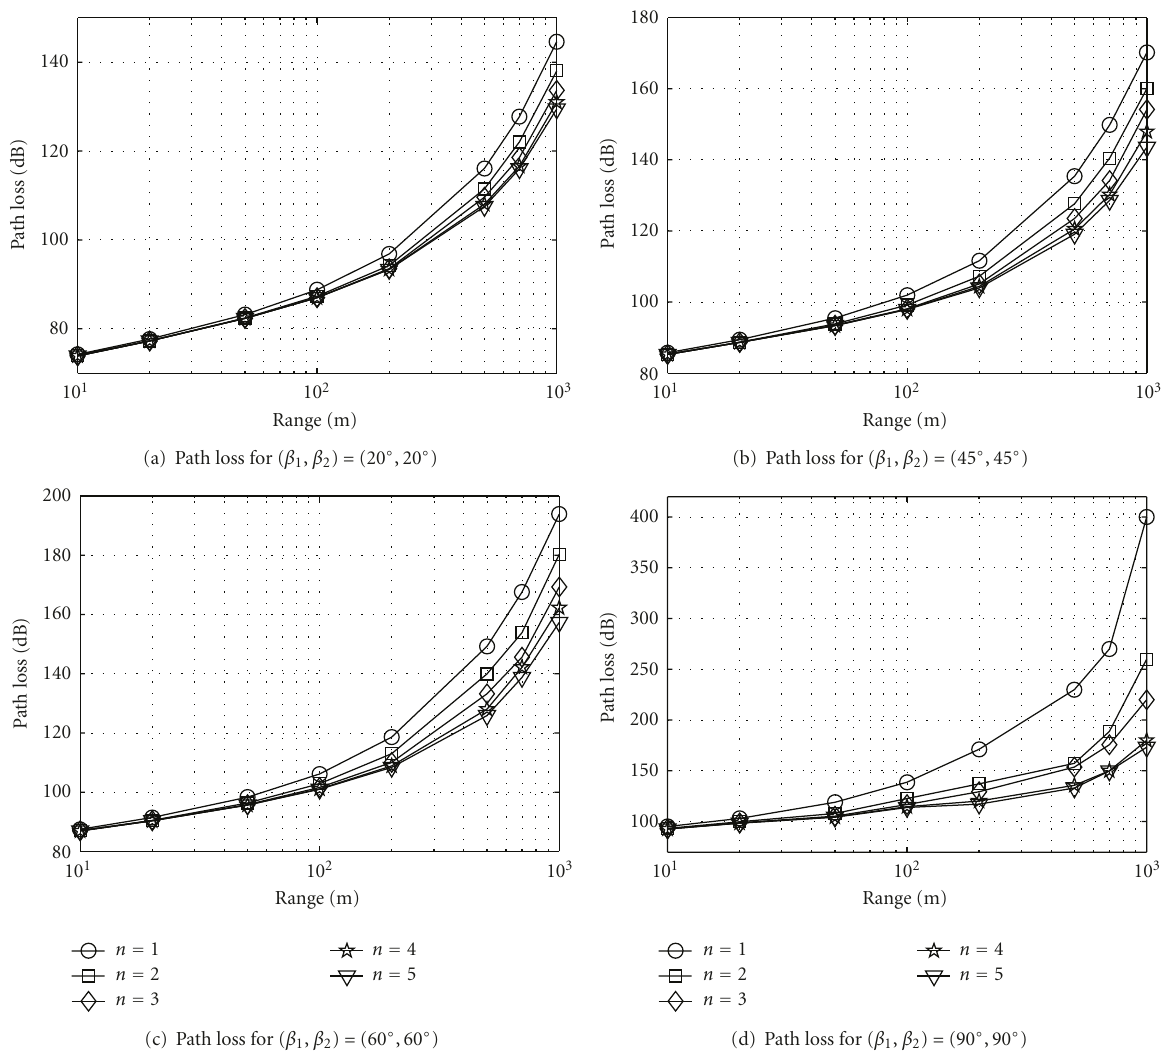
Figure 9: Predicted path loss for extra thick